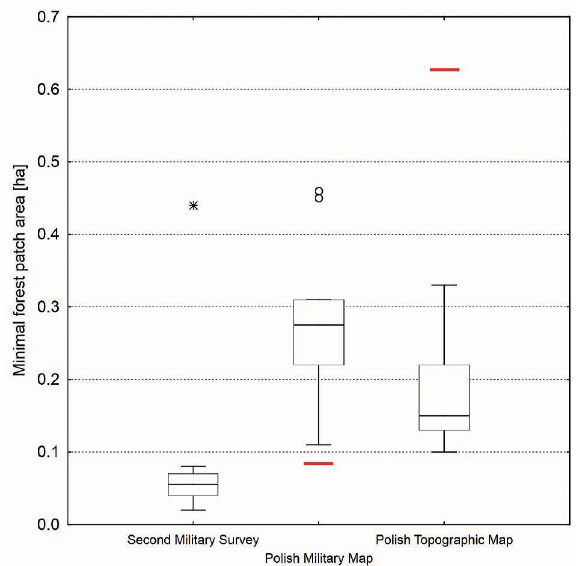
Fig. 1. Minimum forest patches for 10 randomly chosen map sheets for each map set in the Polish Carpathians; lines in red show the value defined by map instruction (not availa- ble for the Second Military Survey Map)